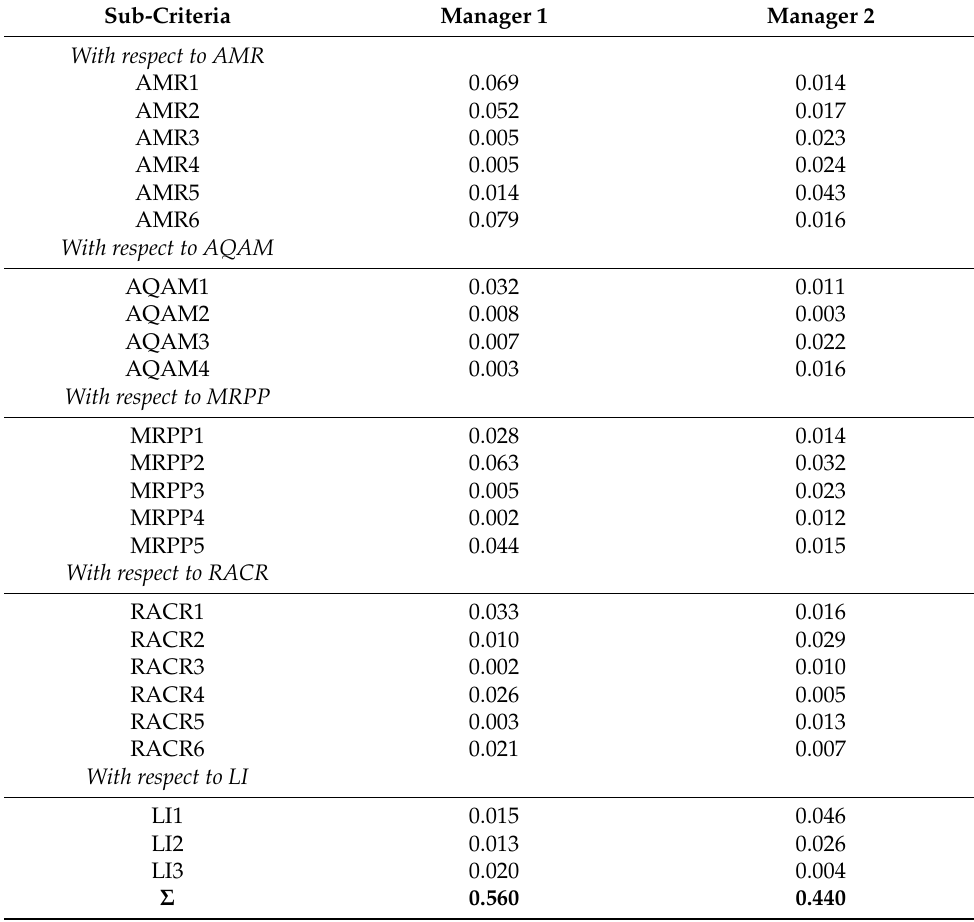
Table 11. The summarized results.